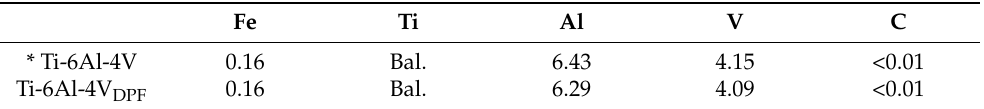
Table 4. OES chemical analysis of the produced alloys (wt-%). Fe Ti Al V